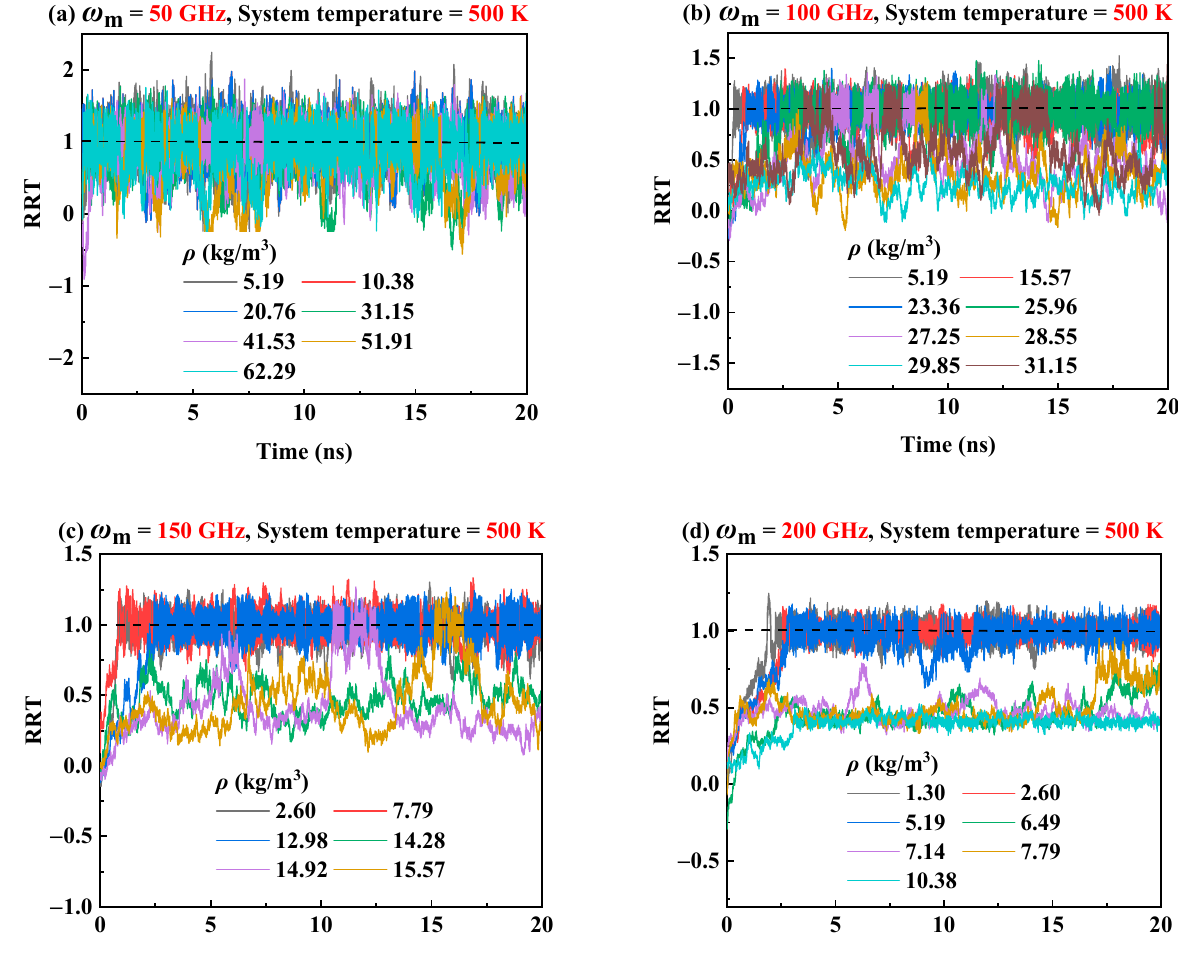
Figure 7. The curves of RRT at 500 K in helium environment when ( a ) ω m = 50 GHz, ( b ) ω m = 100 GHz, ( c ) ω m = 150 GHz, and ( d ) ω m = 200 GHz.